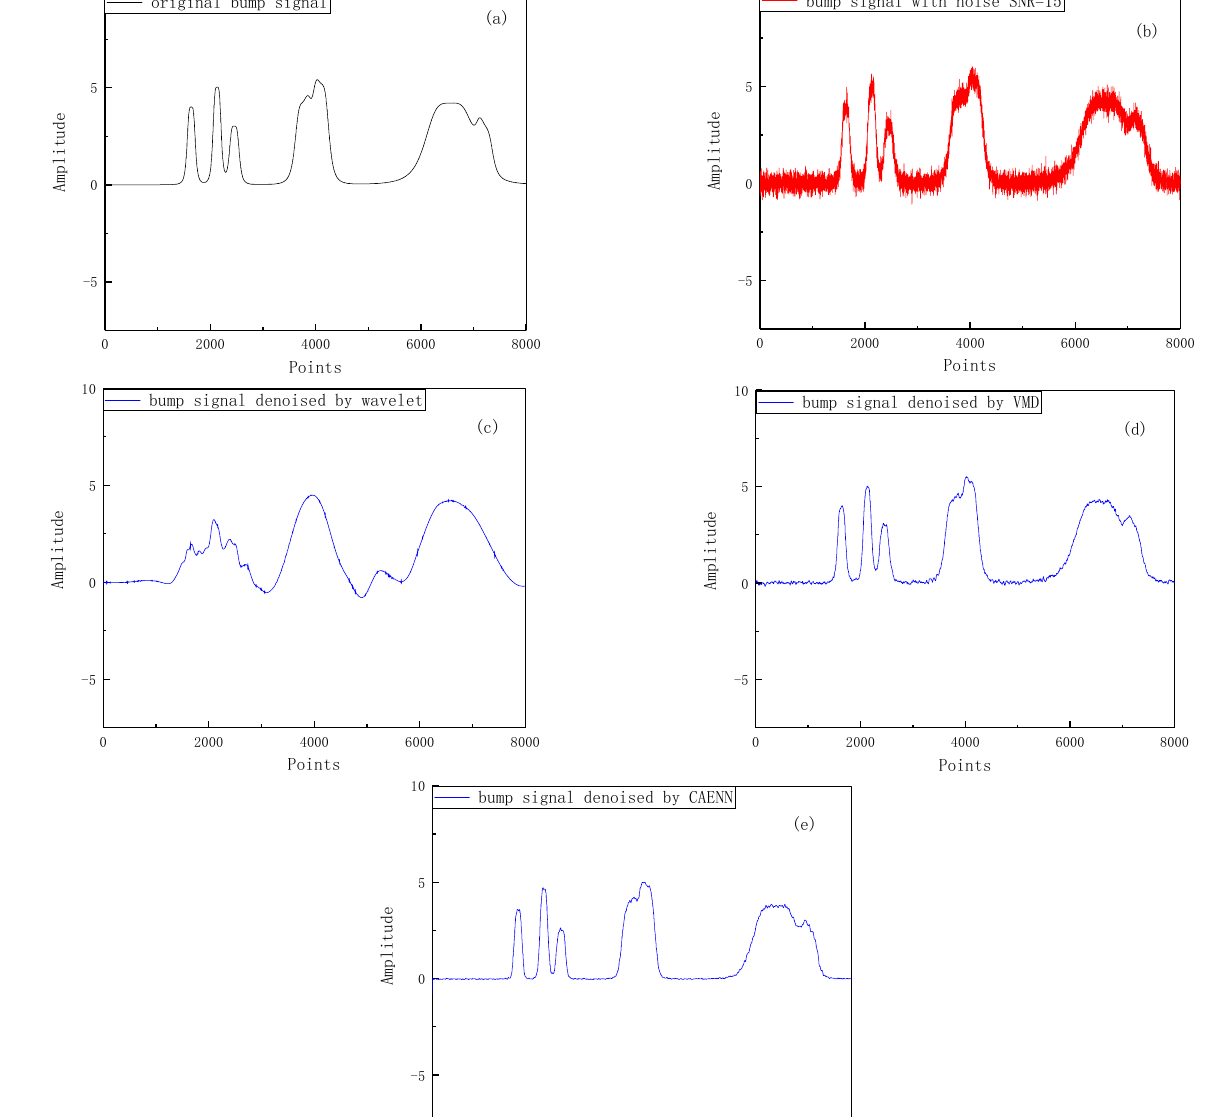
Figure 8. The simulated noise reduction effects of Bump signals. ( a ) the original bump signal, ( b ) the bump signal with SNR = 15 noise, ( c ) the signal processed by the wavelet threshold method, ( d ) the signal processed by the VMD method, ( e ) the signal processed by CAENN method.